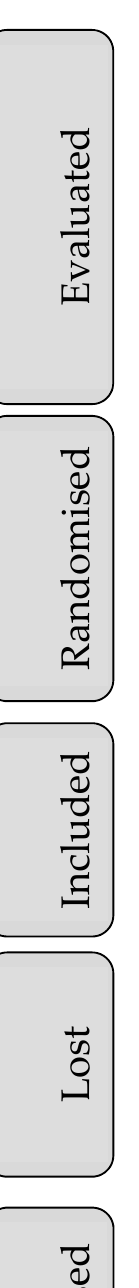
Table 1. Sociodemographic and anthropometric data.